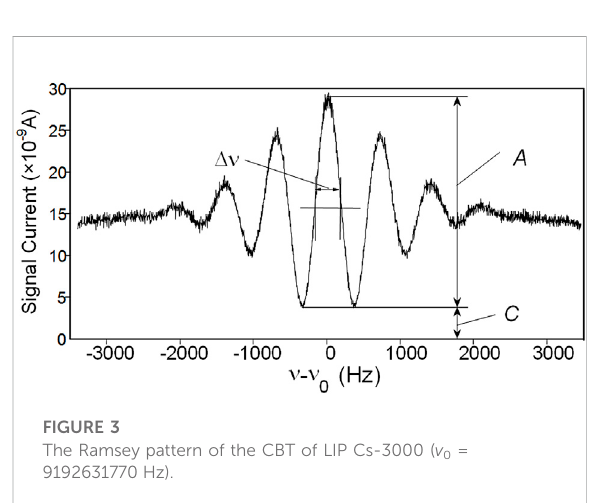
FIGURE 3 The Ramsey pattern of the CBT of LIP Cs-3000 ( v 0 = 9192631770 Hz).